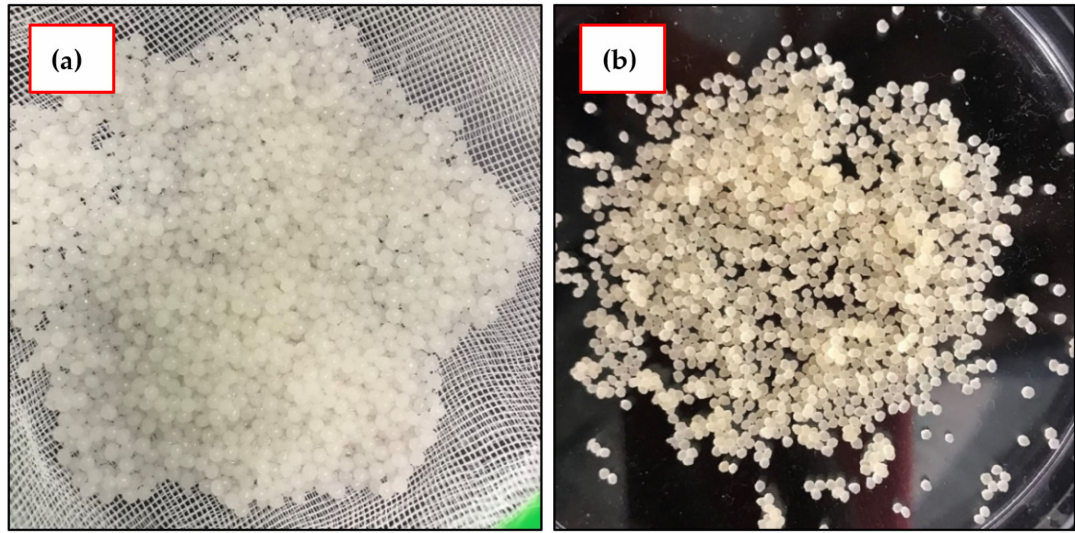
Figure 3. The prepared IL–agar–alginate beads ( a ) wet and ( b )